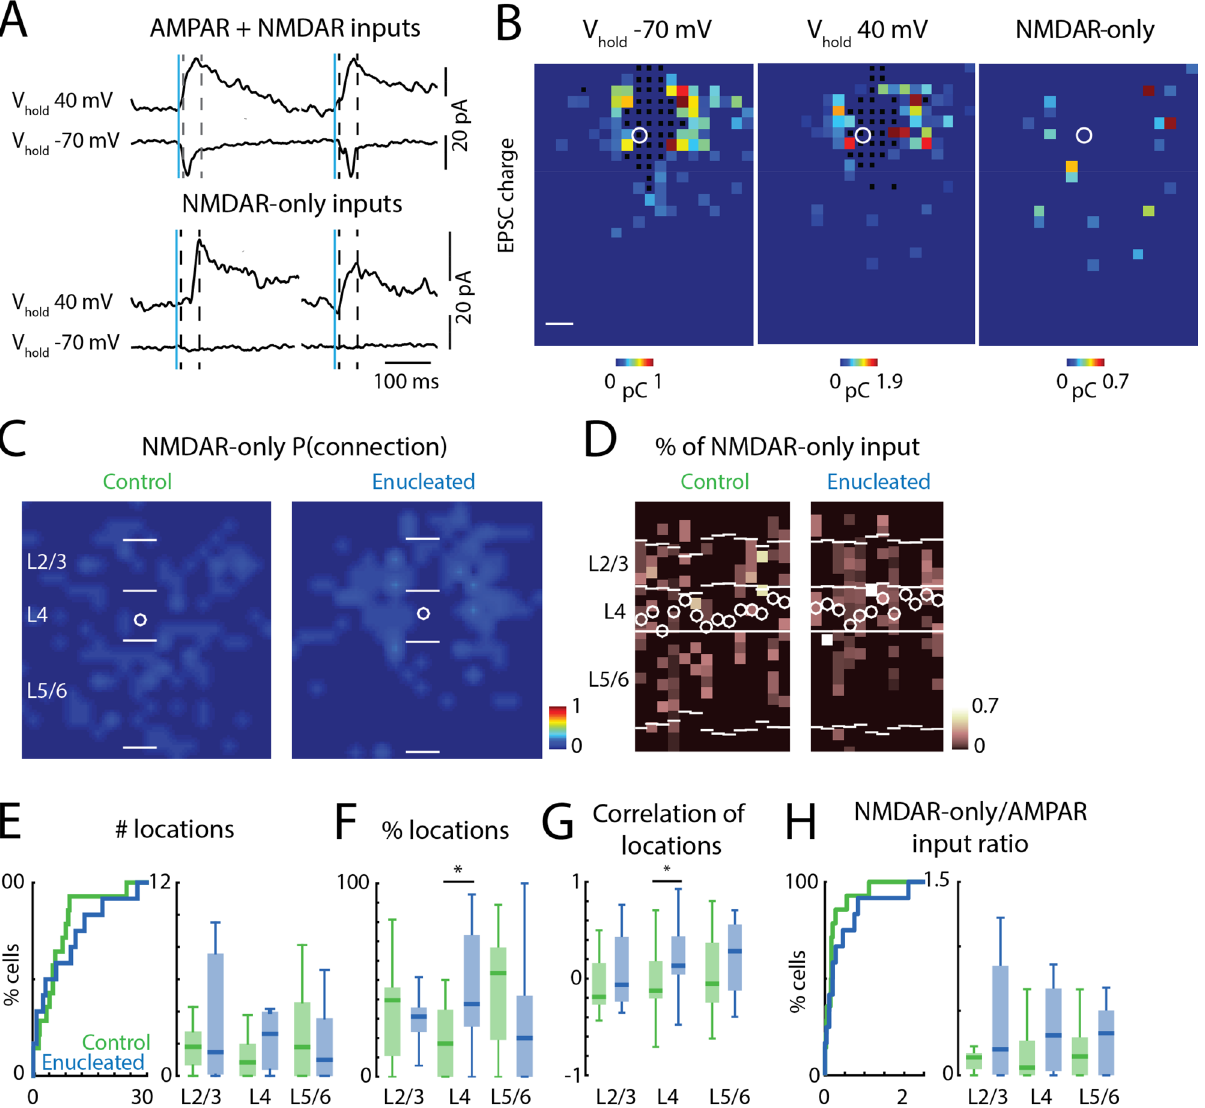
Figure 4. NMDAR-only cortical inputs to Gad2 interneurons. ( A ) Example recordings of AMPAR-mediated inputs (upper traces) and NMDAR-only inputs (lower traces). Blue line indicates photostimulation time point. Dashed lines indicate the time window (10 to 50 ms post-uncaging) for identifying putative monosynaptic responses. ( B ) Example input maps from one recorded GABAergic interneuron. Responses to photostimulation are reconstructed based on the stimulation locations. Left, AMPAR-mediated input map; middle, AMPAR + NMDAR input map; right, NMDAR-only input map. Monosynaptic responses are color-coded based on the EPSC transferred charge (pseudocolor scale below each panel). Black squares indicate direct responses of the patched neuron to photosimulation. The white circle indicates soma location. Slice orientation is the same as in Fig. 1B. Scale bar is 100 μm. ( C ) Average spatial connection probability maps of NMDAR-only inputs received by L4 Gad2 interneurons in V1 at P16/P17 in control and enucleated animals (n = 14 control and n = 12 enucleated, same cells as in Fig. 2C). ( D ) Laminar distribution of NMDAR-only inputs for each cell. Plotted is the fraction of input each cell received at each laminar location. Layer borders for each cell are indicated by horizontal white lines. Soma locations are indicated by white circle; cells are aligned to L4. ( E ) Quantification of the number of input locations. CDF of the total number of input locations (left). P > 0.05. Boxplot shows the number of input locations in each layer group (left). All P > 0.05. ( F ) Boxplot of the average fraction of inputs from each layer. (*) indicates P < 0.05, otherwise P > 0.05. ( G ) Boxplot of the correlation of input locations from each layer originate. (*) indicates P < 0.05, otherwise P > 0.05. ( H ) Quantification of NMDAR-only inputs to AMPAR-mediated inputs ratio for each cell (left) and for each layer group (right). P > 0.05. For all panels: green, control group; blue, enucleation group. Statistics for E (left) and H (left) are in the main text. Statistics for ( E ) (right), ( F ), ( G ) and ( H ) (right) are in Table